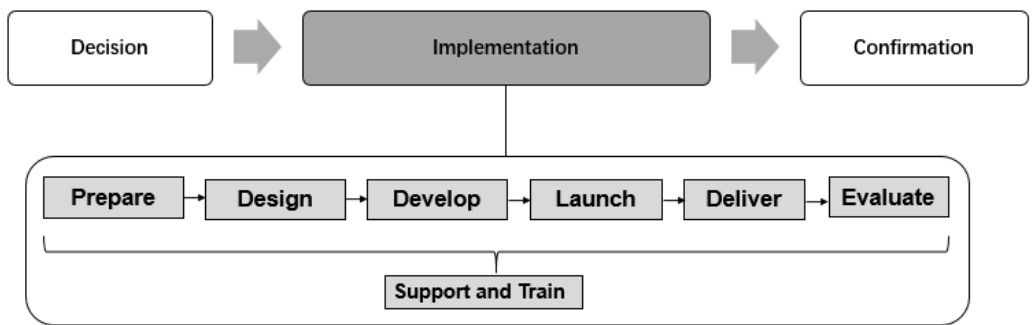
Figure 1. The implementation process of producing MOOCs: A